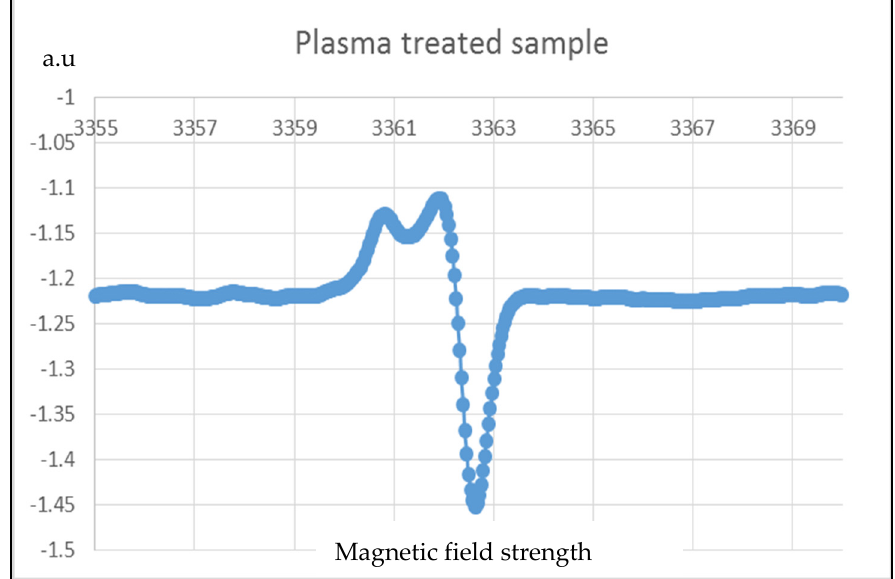
Figure 16. EPR results for corona-treated PVDF sample.